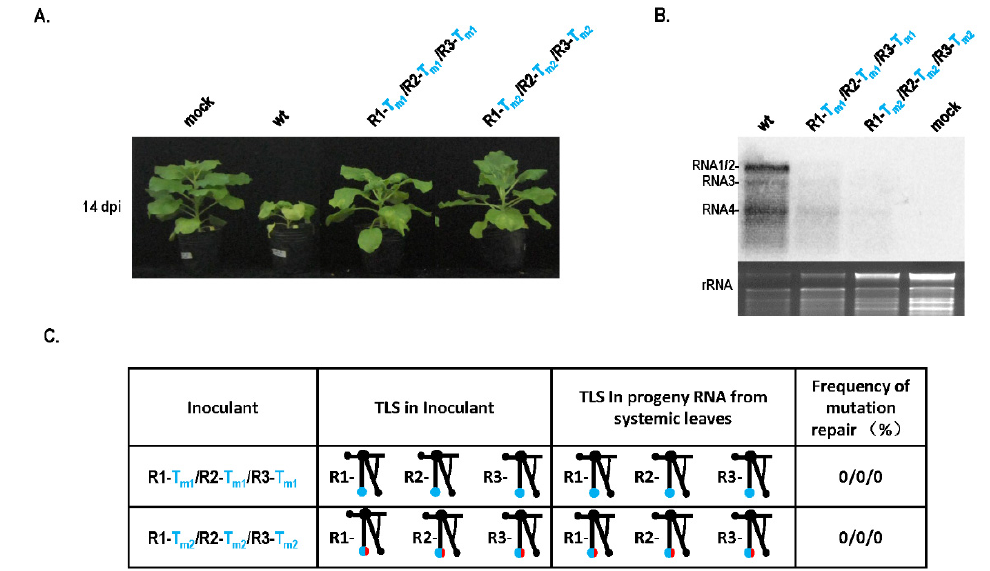
Figure 3. Pathogenicity and mutation repair by mixed infection of TLS mutants in CMV RNAs. ( A ) Pathogenicity of mixed infection of TLS mutants in CMV RNAs. ( B ) Northern blot of RNA samples for mixed infection of TLS mutation. ( C ) Mutation repair analysis of mixed infection of TLS mutants in different RNAs of CMV.